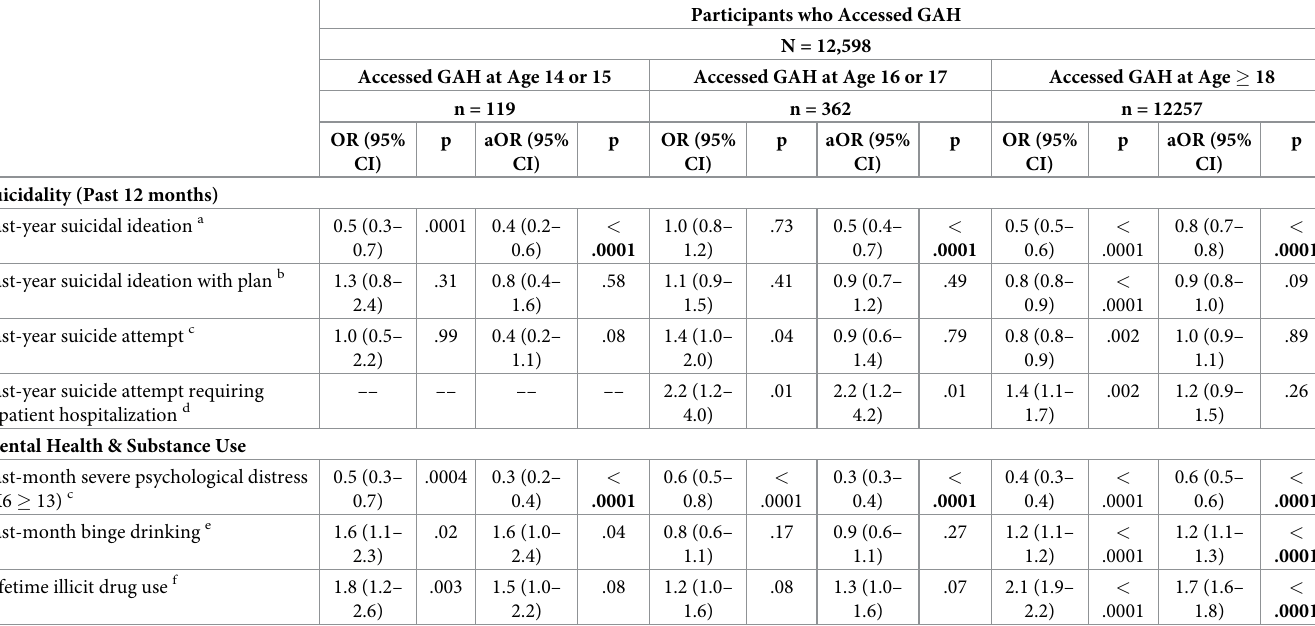
Table 2. Outcomes for participants who accessed gender-affirming hormones (estrogen or